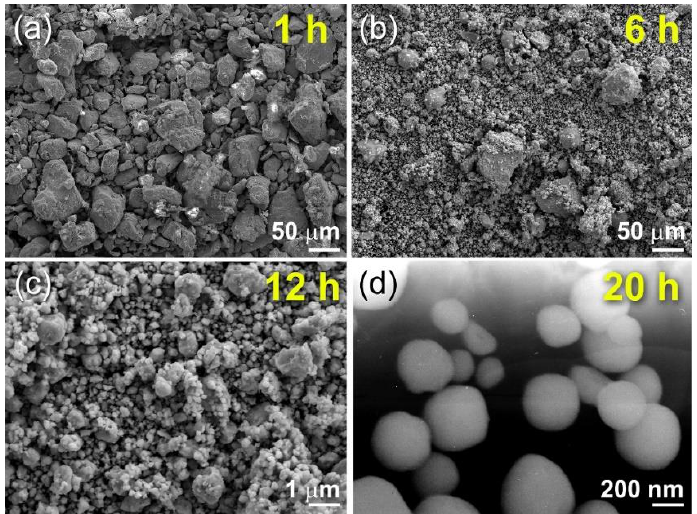
Figure 31. FE-SEM micrograph of the powder samples obtained after ( a ) 1 h, ( b ) 6 h, ( c ) 12 h, and ( d ) 20 h of RBM. 20 h of